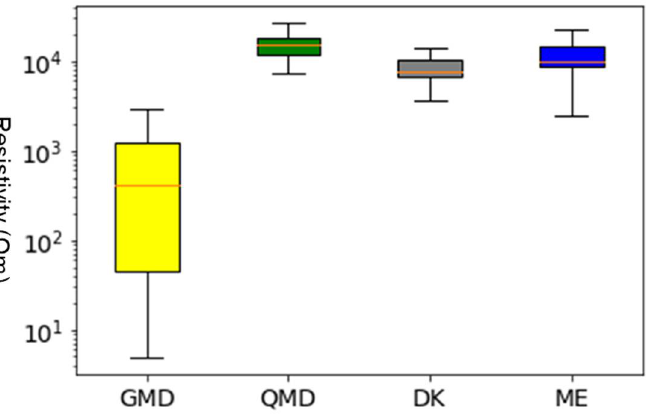
Figure 8. Box plots of measured resistivity according to rock type from drilling data (GMD: monzogabbro-monzodiorite, QMD: quartz monzodiorite, DK: dike, ME: metamorphic rock). The red solid lines in the box plots represent the median value of each rock type.